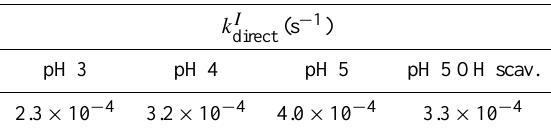
Table 2. Rate constants for photo-enhancement at 420nm for 4- nitrocatechol (4NC).